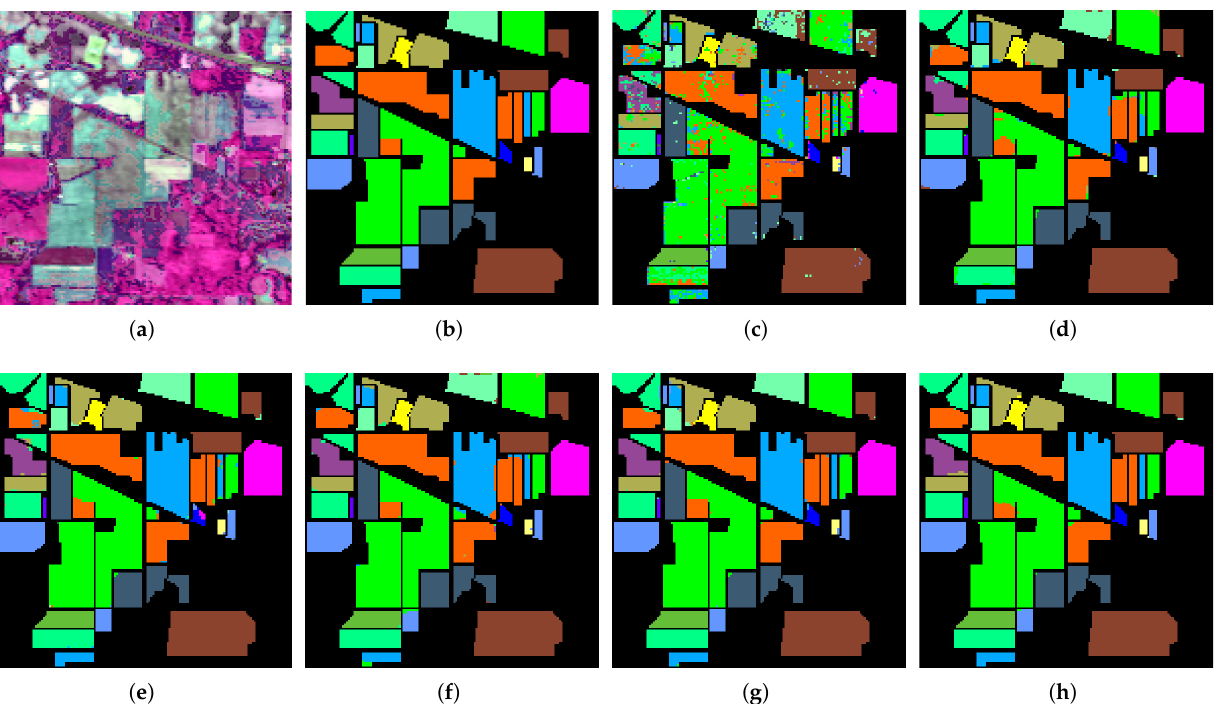
Figure 11. Classification performance of different network models over IP dataset. ( a ) False-color image. ( b ) Ground truth. ( c ) SVM. ( d ) 3-D CNN. ( e ) FDMFN. ( f ) DenseNet. ( g ) PresNet. ( h ) PDCNet.